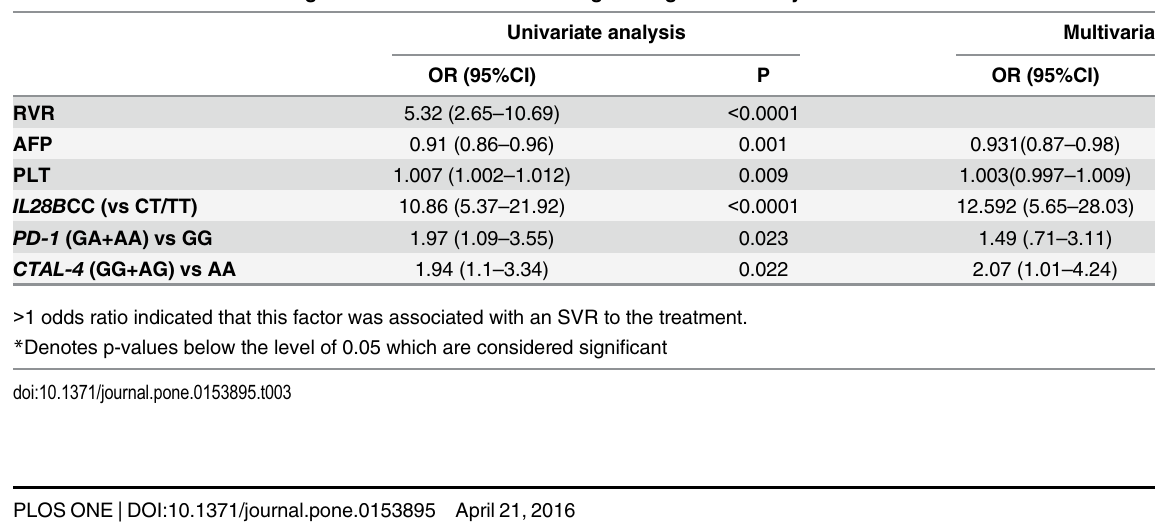
Table 3. Predictors of SVR using univariate and multivariate logistic regression